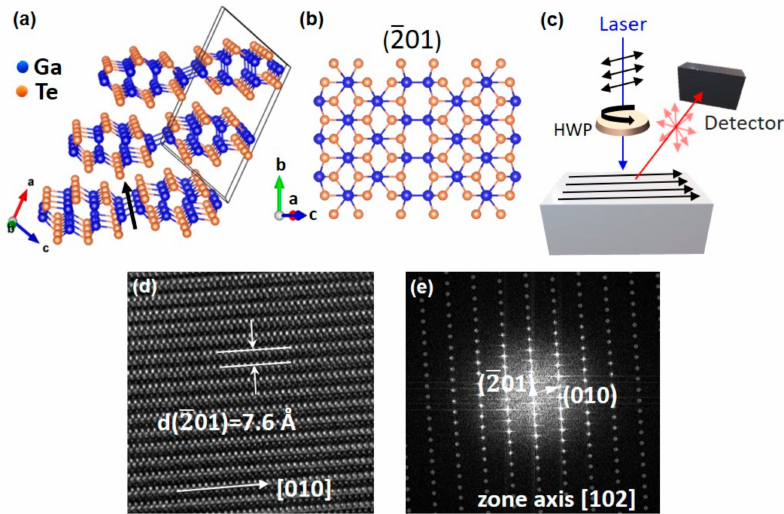
Figure 1. Crystal structure of layered gallium telluride (GaTe) flakes; ( a ) Schematic showing the monoclinic unit cell and the b -axis (black arrow) of the crystal; ( b ) Projection along normal to (201) of monolayer GaTe showing the formation of pseudo-1D chains of Ga–Ga bonds (blue spheres) along the b -axis; ( c ) Schematic of the experimental setup for polarization-dependent photoluminescence measurements using a half waveplate (HWP); ( d ) High-resolution transmission electron microscopy (HRTEM) image of a GaTe flake showing the interlayer spacing for (201) and [010] chain, b -axis, direction. The spacing between the lattice fringes was ~7.6 Å, which is close to the reported thickness (~7.5 Å) for monolayer GaTe [14]; ( e ) FFT (Fast Fourier Transform) image along the [102] zone axis showing periodicity of {201} and {010} family of